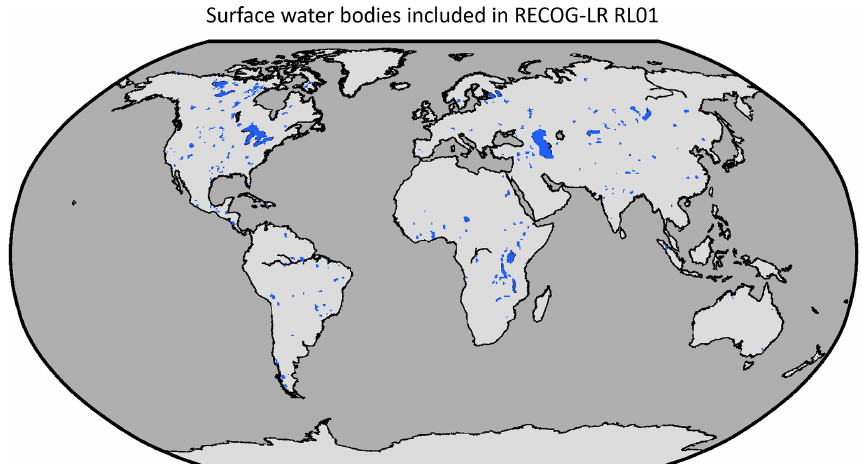
Figure 2. Overview of all 283 lakes/reservoirs in the dataset (blue areas) given on a 0.5 ◦ grid.